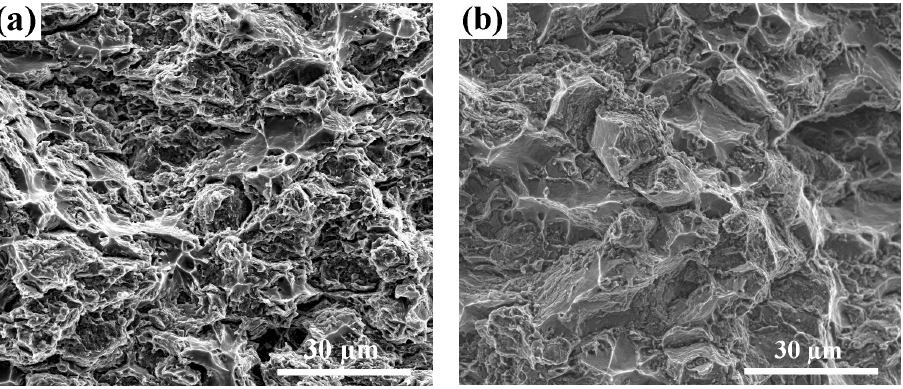
Figure 10. Fractographs of the 2024 alloy tested at temperatures of ( a ) 25 °C and ( b ) 300 °C.